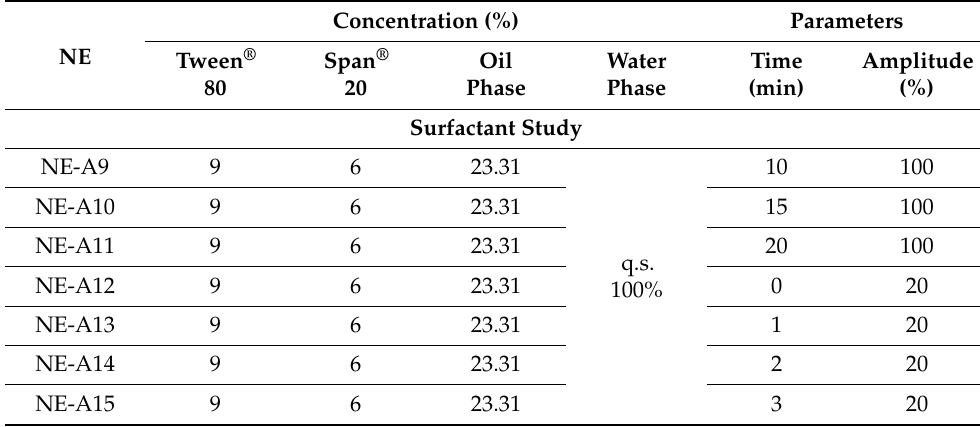
Table 3. Composition of NEs and ultrasound parameters (NE-A9 to